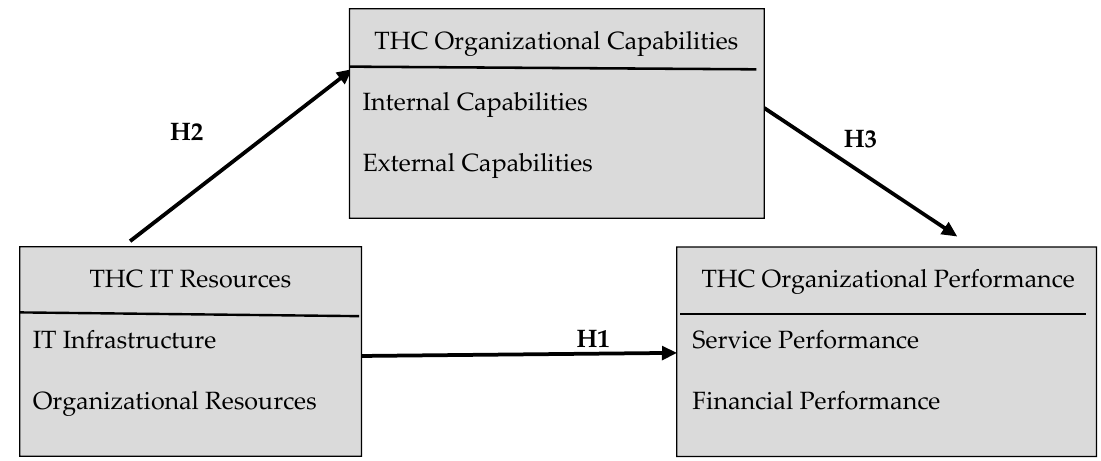
Figure 1. Conceptual framework. THC: telehealth care.